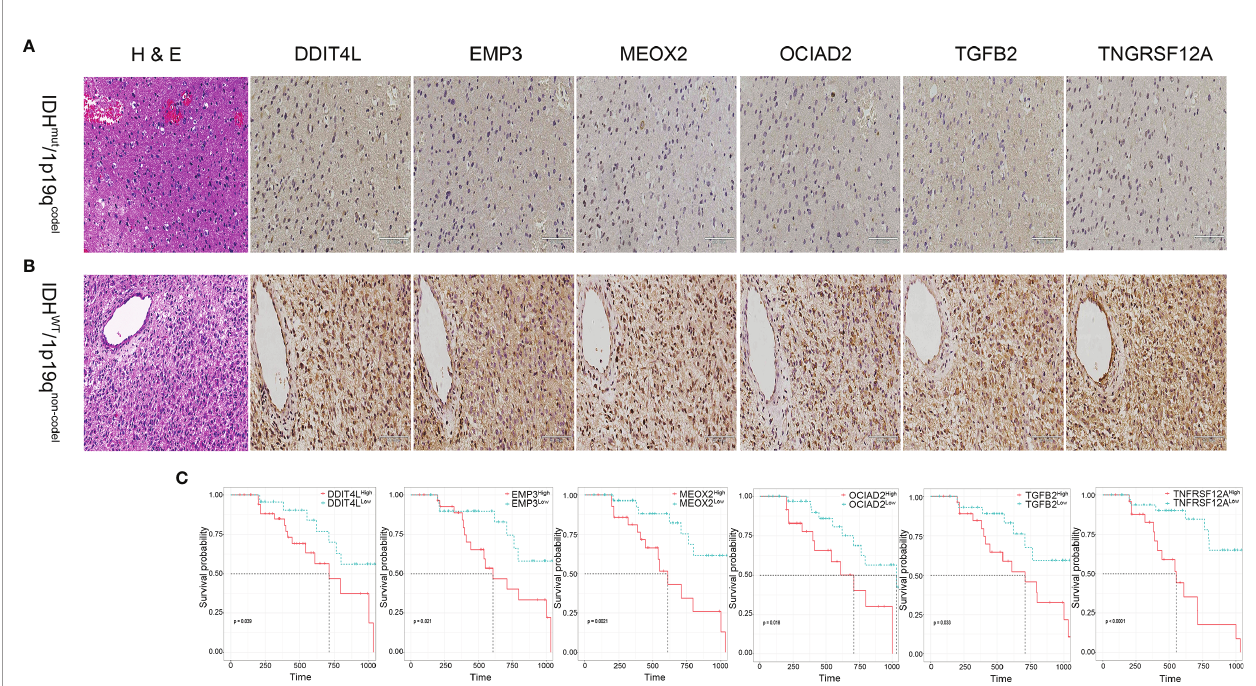
FIGURE 6 | Validation of the transcriptional risk score using IHC staining in clinical samples. (A, B) Representative IHC images of risk gene cluster in glioma tissues samples. Upper panel, IDH mut /1p19q codel . Lower panel, IDH wt /1p19q non-codel . (C) The Kaplan – Meier survival analysis for risk gene cluster derived from DDIT4L expression, EMP3 expression, MEOX2 expression, OCIAD2 expression, TGFB2 expression, and TNFRSF12A expression classi fi ed by IHS using our clinical samples, respectively (all p < 0.05, with log-rank